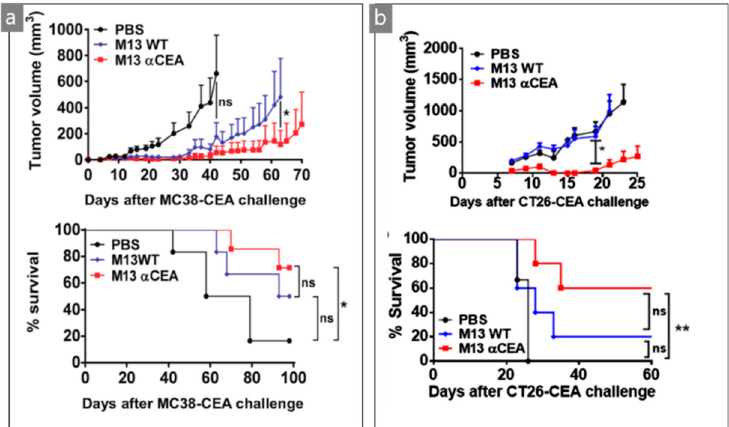
Figure 5. Growth of different CEA tumors (( a ) MC38-CEA, ( b ) CT26-CEA) and survival of mice treated with M13 bacteriophage with or without α CEA. Reproduced from [44], with permission from Springer Nature, 2017.